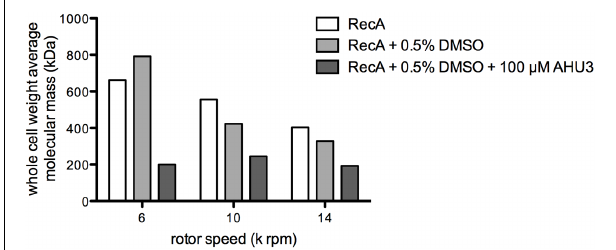
FIGURE 7 | AHU3 decreases RecA oligomerization. Whole cell weight average molecular mass of RecA at AUC rotor speeds of 6, 10, and 14 k rpm. Ten micrometer RecA was studied alone, in the presence of 0.5% DMSO, and in the presence of 0.5% DMSO and 100 µ M